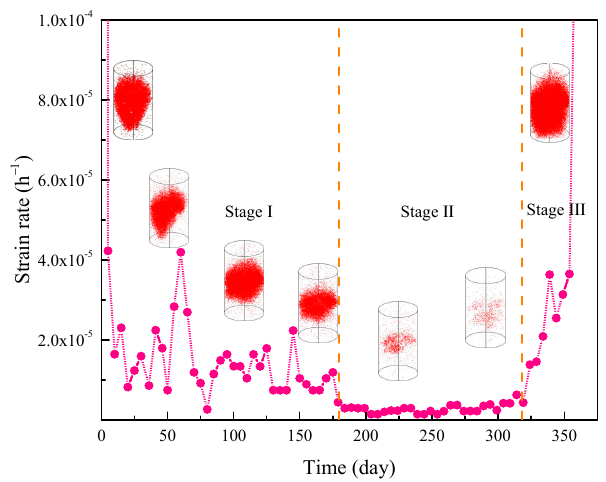
Figure 3. The strain rate and spatial distribution of AE events. The inset images show the spatial distribution characteristics of AE events in the different creep stages.